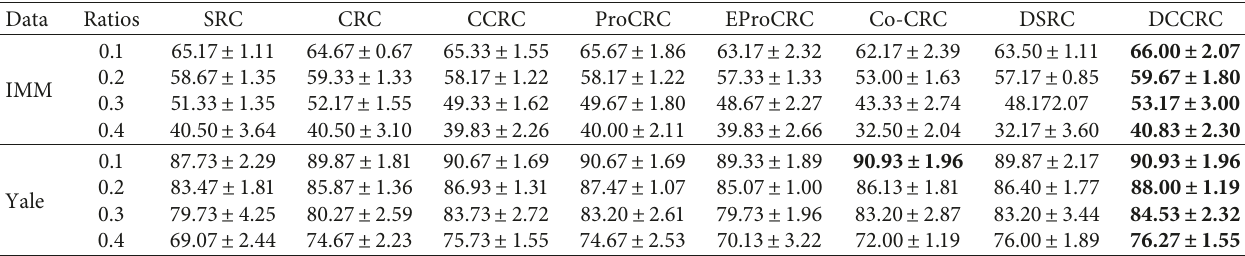
Table 6: The classification accuracies (%) of the competing methods with the corresponding standard deviations under the situations of the random pixel corruptions.